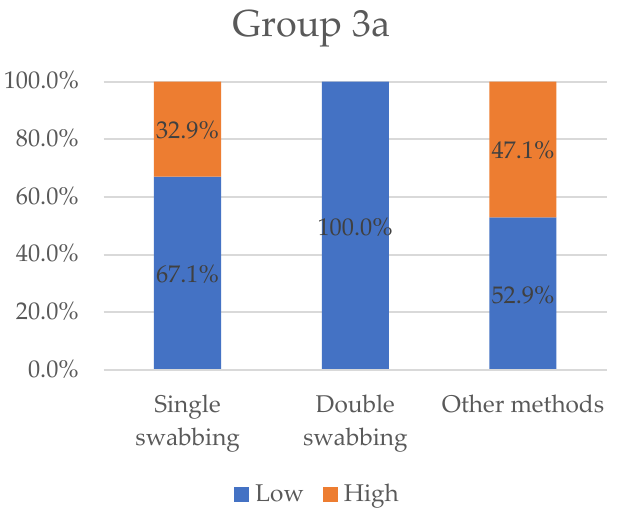
Figure 5. Variables “low” and “high” grouped by sampling methods for Group 3a. “Low” value represents the totality of results collected for double-swabbing. Single-swabbing and other methods obtained 67.1% and 52.9%, respectively.